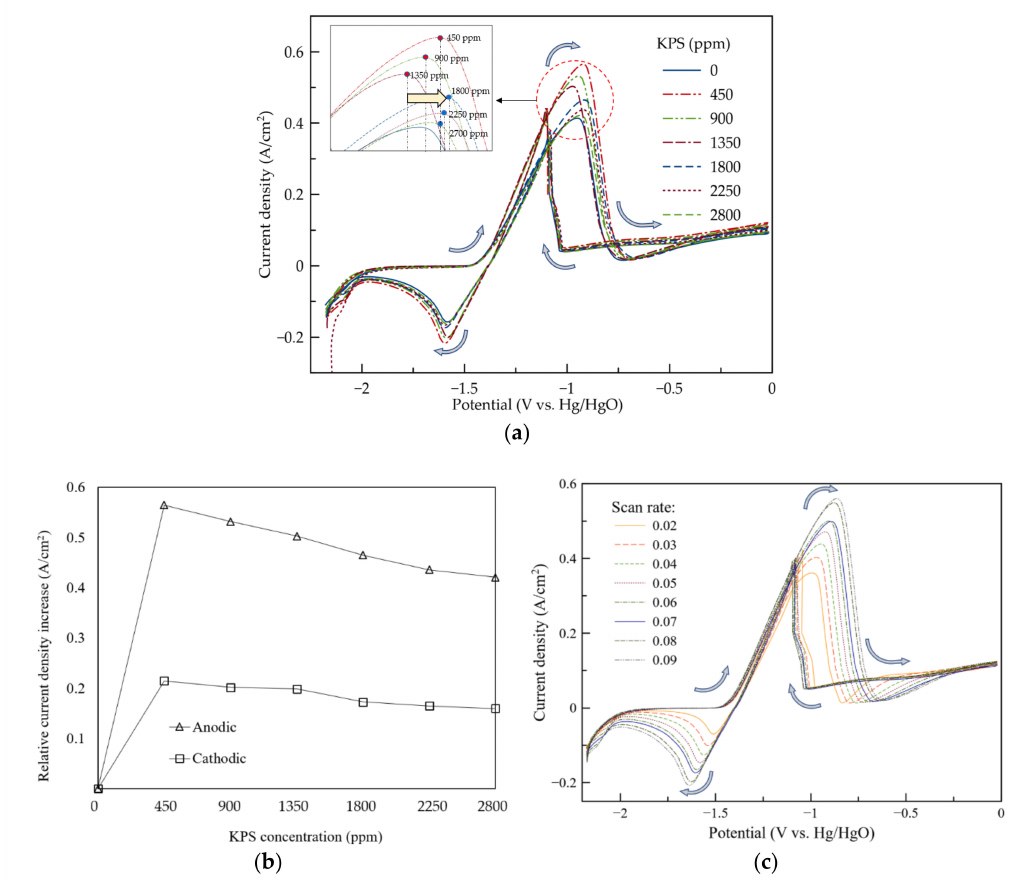
Figure 1. ( a ) Cyclic voltammograms of Zn in di ff erent concentrations of KPS at the scan rate 0.07 V / s. ( b ) The increment of current density in anodic and cathodic peaks of the electrolytes in di ff erent concentrations of KPS relative to the additive-free electrolyte. ( c ) Cyclic voltammograms of Zn in 450 ppm KPS at various scan rates (0.02, 0.03, 0.04, 0.05, 0.06, 0.07, 0.08 and 0.09 V /